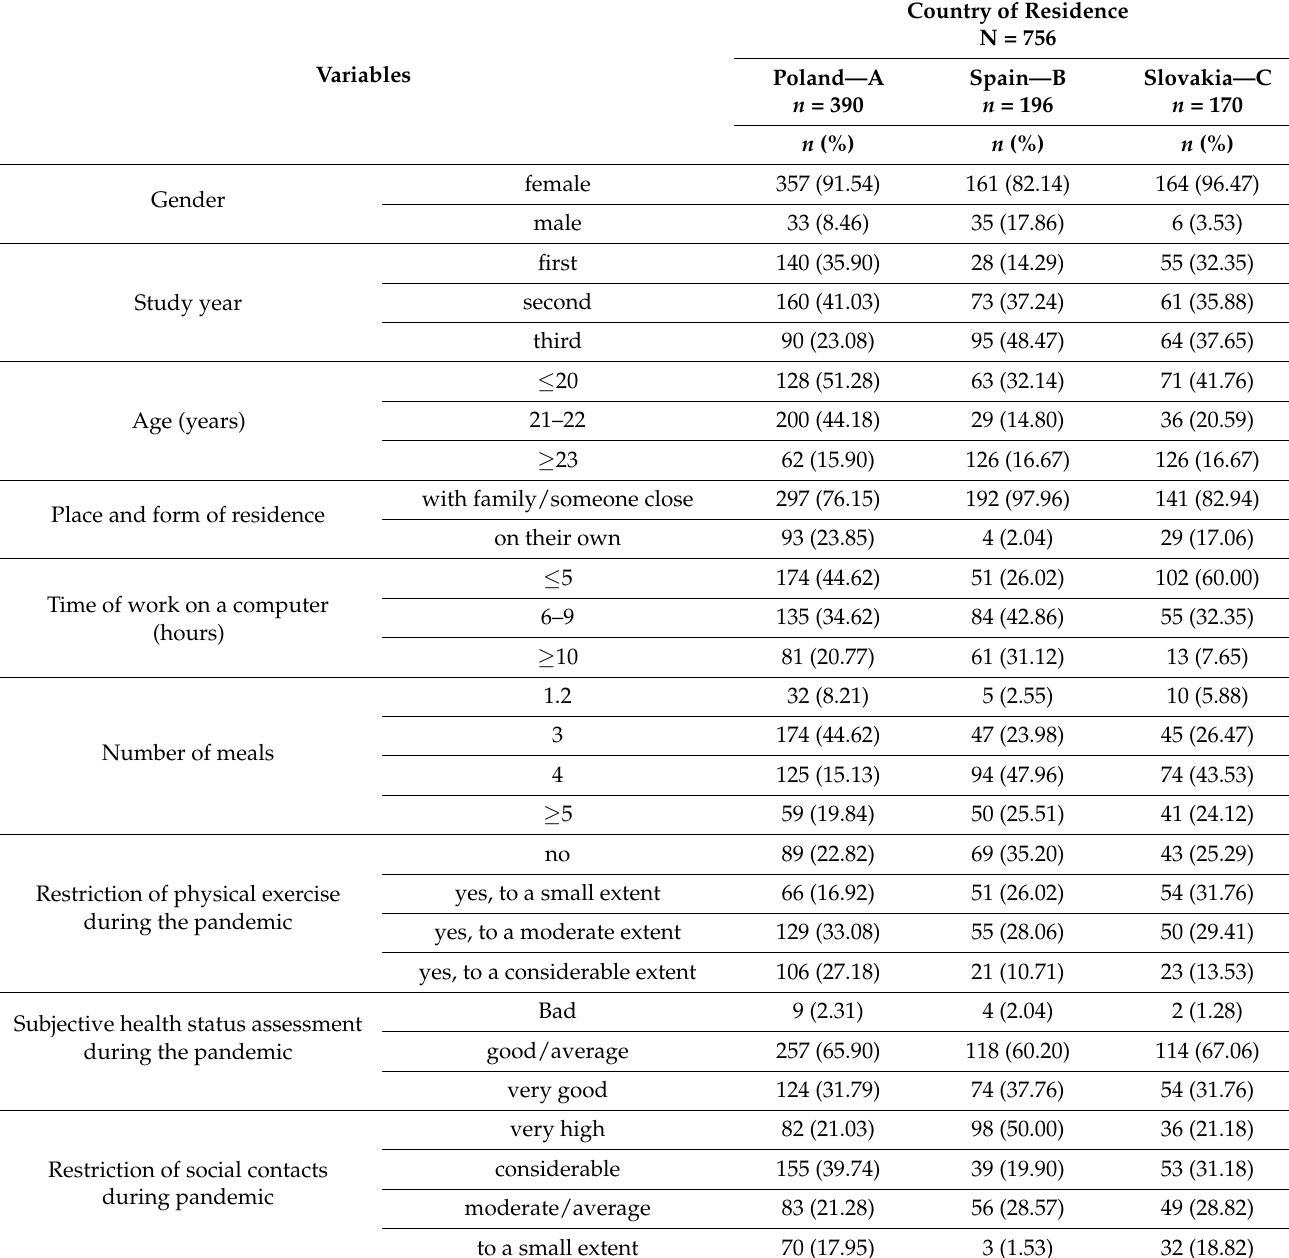
Table 1. Characteristics of the